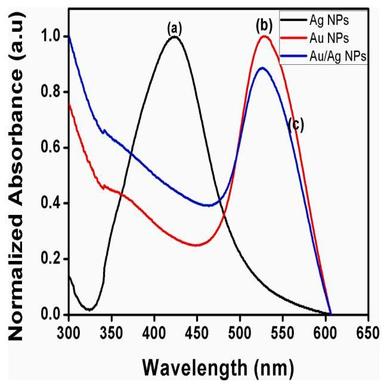
UV–visible spectra of (a) Ag-NPs (b) Au-NPs and (c) Au/Ag-NPs.